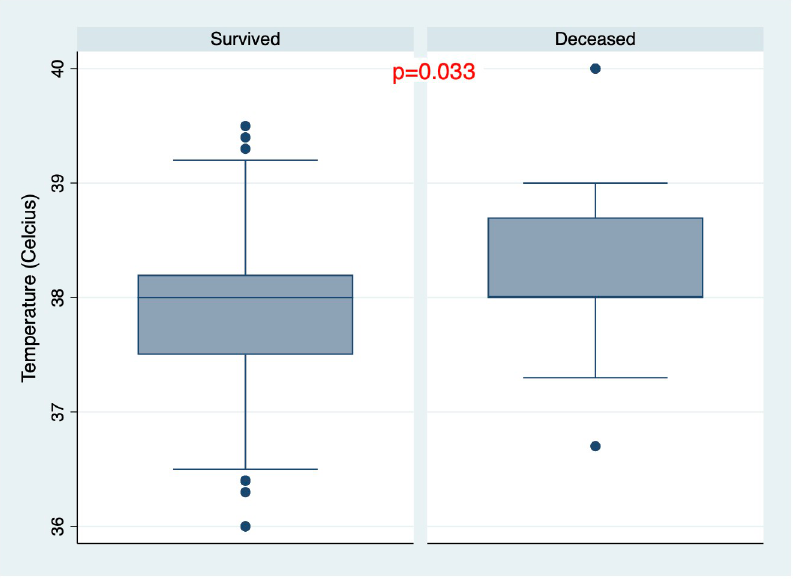
Fig 3. Temperature distribution among survived and deceased